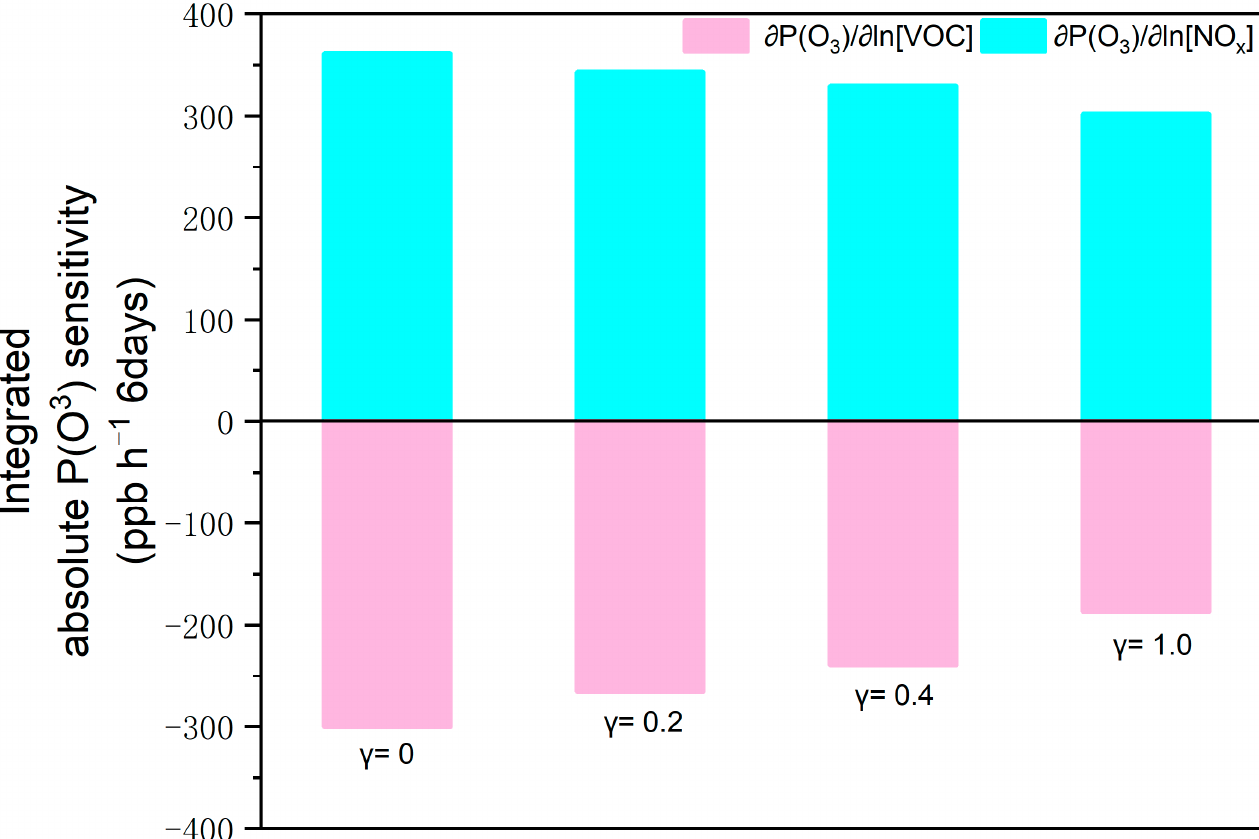
Figure 7. Impacts of uptake coefficients on the total absolute P ( O 3 ) sensitivity from 22 March to 27 March 2020